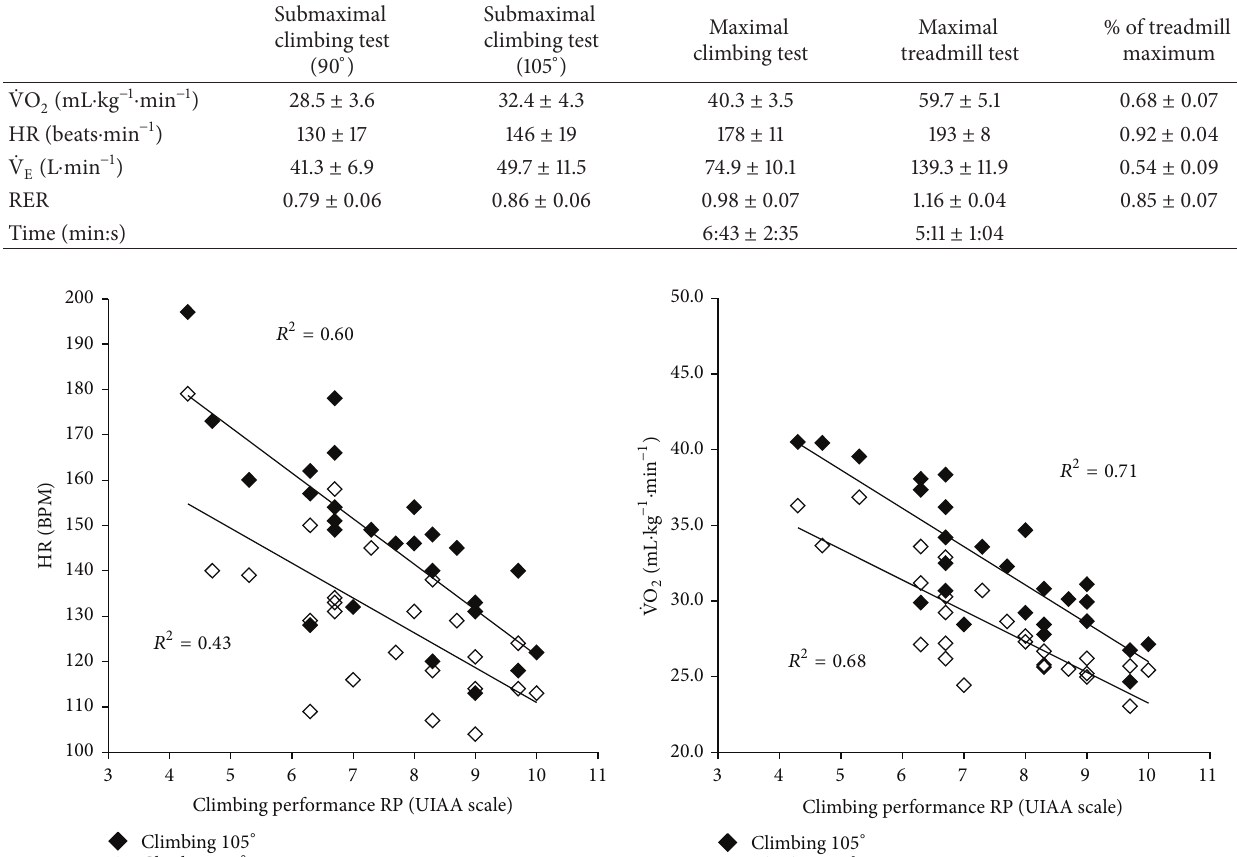
̇ VO 2 ) and heart rate (HR) during submaximal climbing